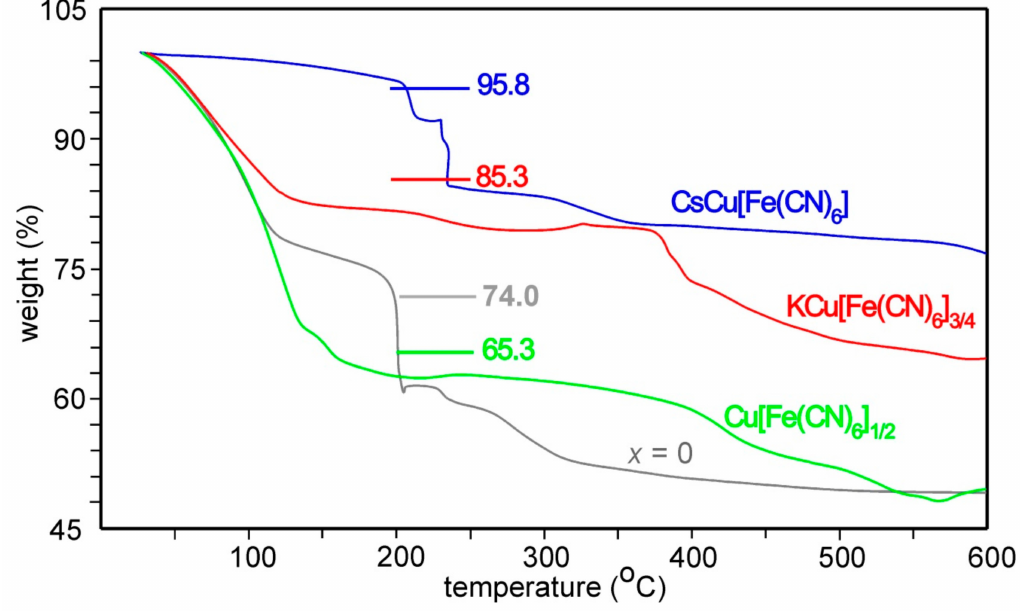
Figure5. TGcurvesforwater-containingCu[Fe(CN) 6 ] 1 / 2 (green), KCu[Fe(CN) 6 ] 3 / 4 (red), CsCu[Fe(CN) 6 ] (blue), and x = 0 (grey) samples upon heating in air at a rate of 10 ◦ C /